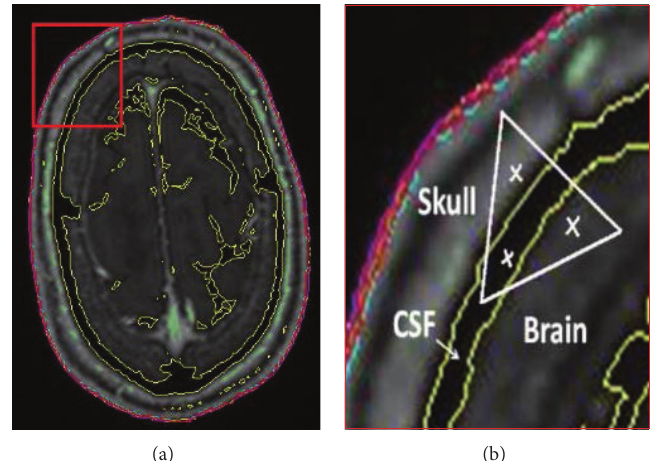
Figure 2: (a) QCT image and a concerned region zoomed in (b); (b) Gaussian quadrature points located in three different